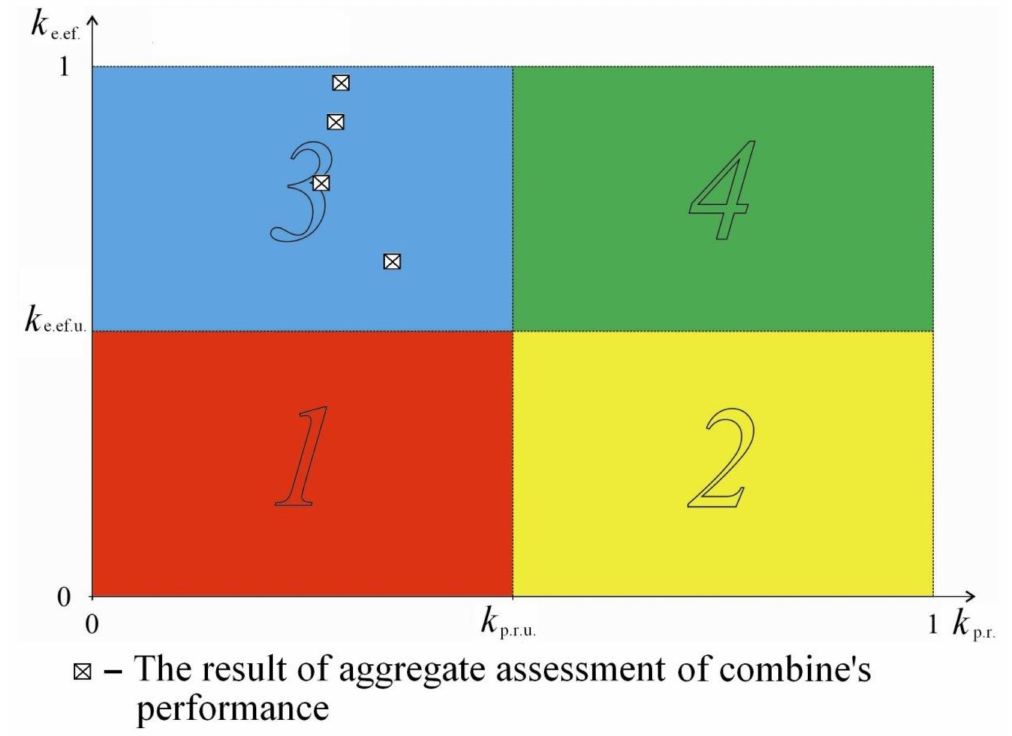
Figure 2. Zones for possible values of k p.r. and k e.ef.